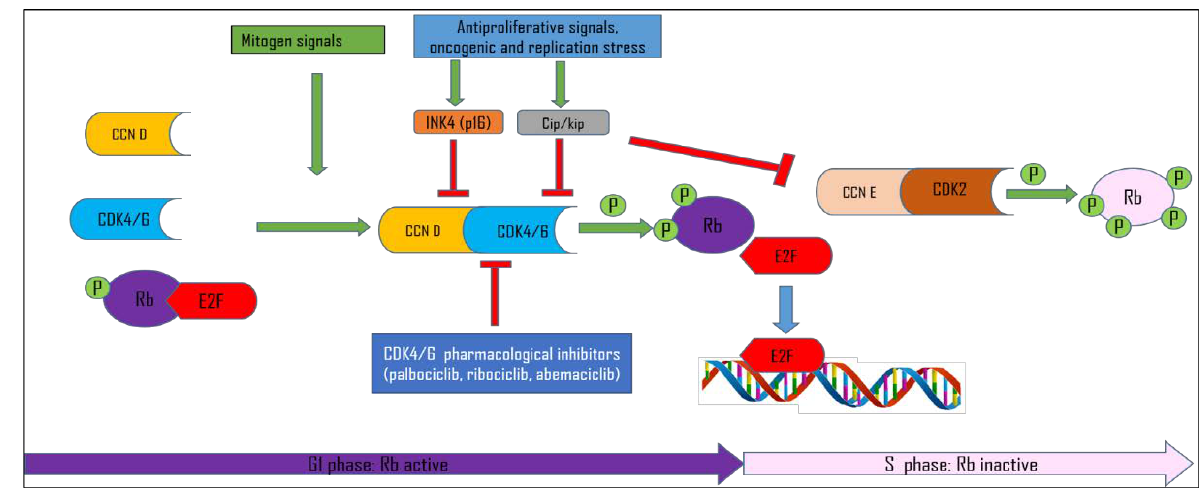
Figure 1. RB pathway and G1/S cell cycle control. Cyclin (CCN); Cyclin-dependent kinase (CDK); Retinoblastoma protein (RB); E2F transcription factor (E2F).